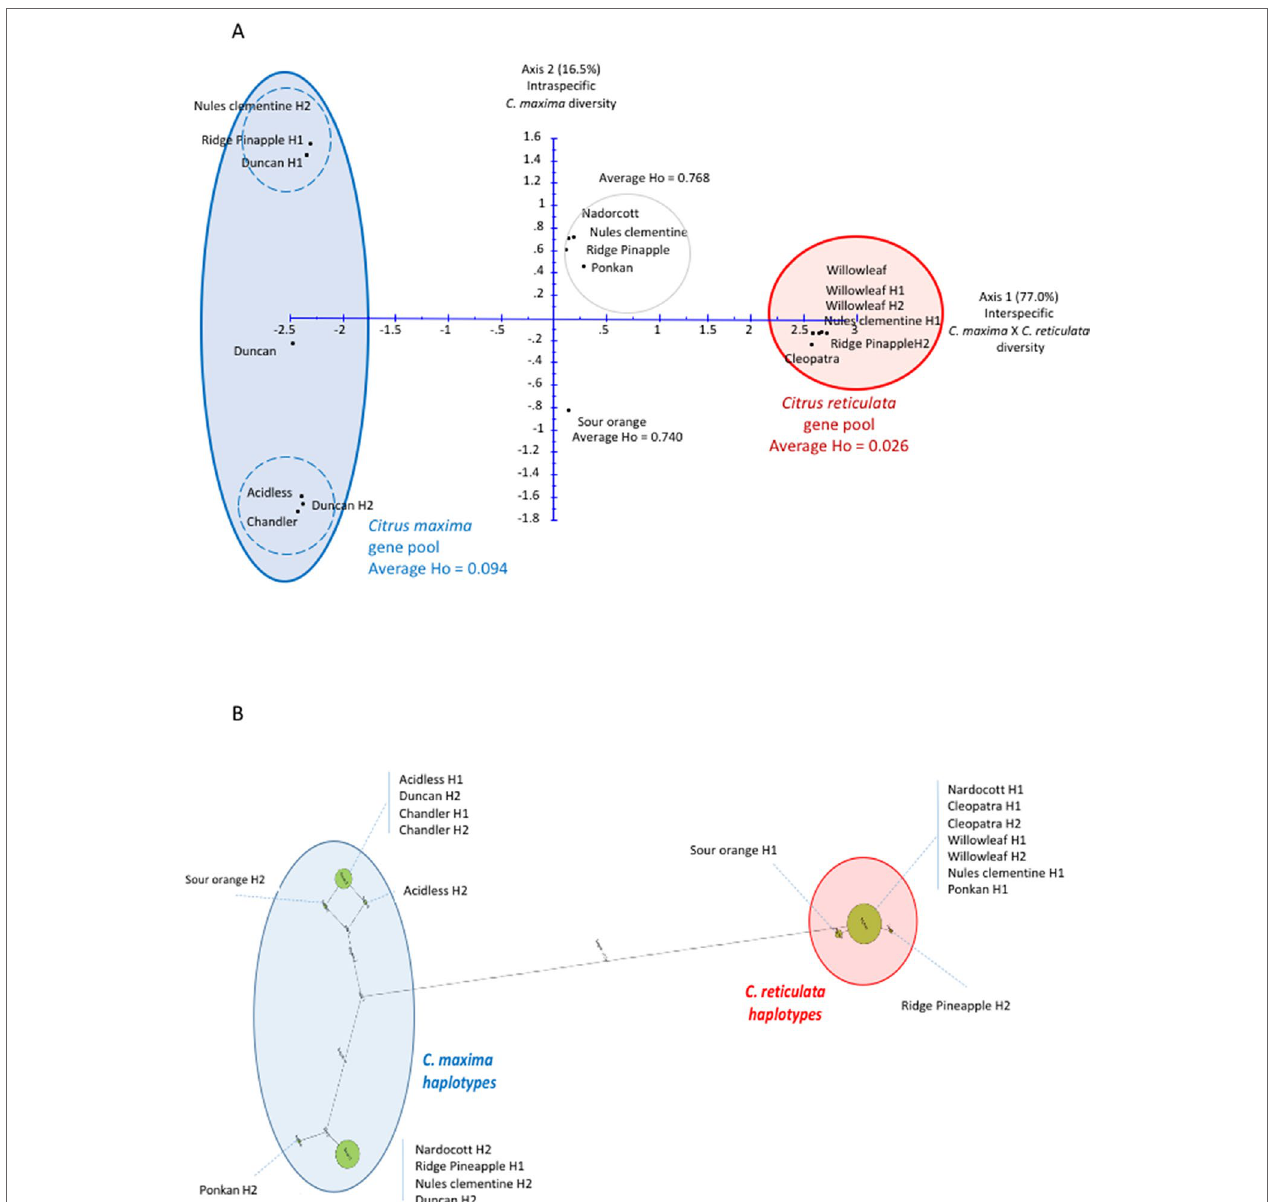
FIGURE 2 | Factorial and haplotype analyses for the LCY-b gene. (A) Factorial analysis. H1 and H2 represent the haplotypes of the indicated corresponding variety. (B) Haplotype network. The size of the cirlces is proportional to haplotype frequency and the length of the lines is proportional to the number of mutation steps between genotypes and their proximal states. H1 and H2 represent the haplotypes of the indicated corresponding